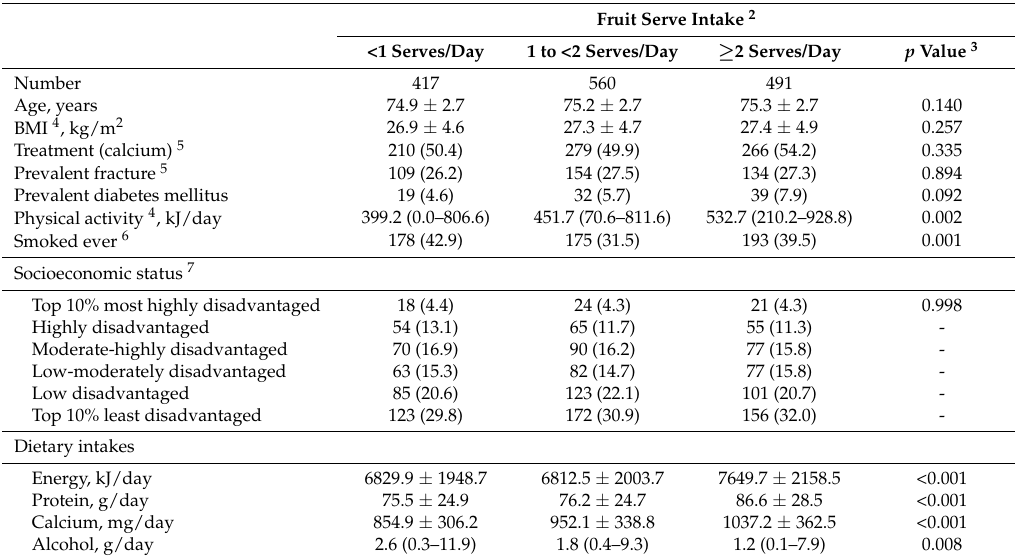
Table 2. Baseline characteristics according to fruit intake categories 1